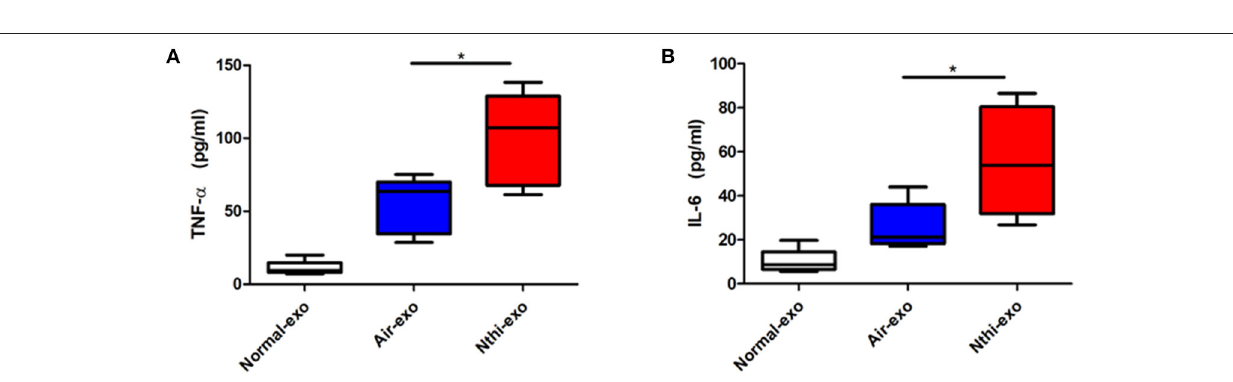
FIGURE 4 | The expression of TNF- α and IL-6in exosomes from the BALF. (A) The levels of TNF- α and (B) IL-6 were analyzed using ELISA. Results are means ± SEM ( n = 5, * P <